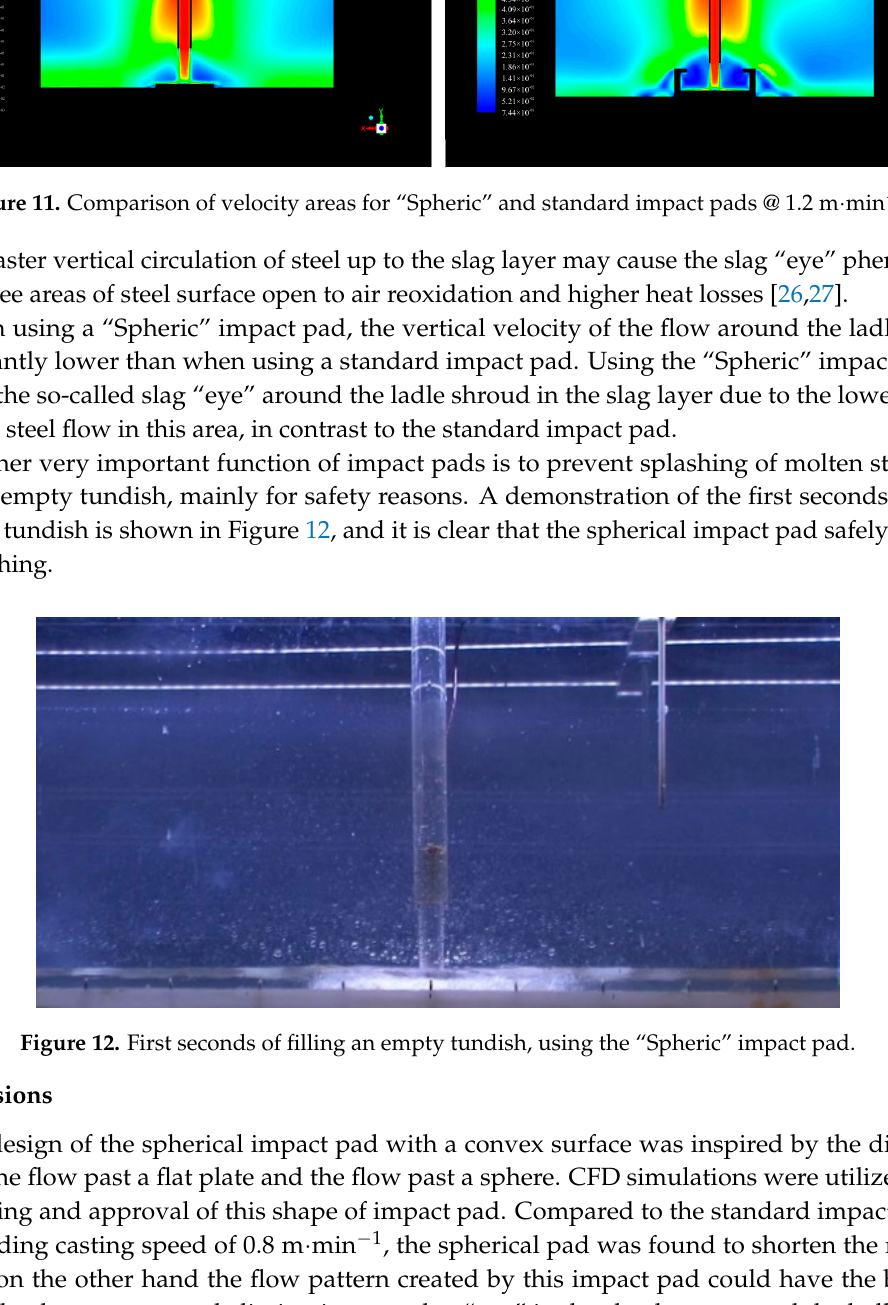
Figure 10. Comparison of velocity areas for “Spheric” and standard impact pads @ 0.8 m min − 1 .